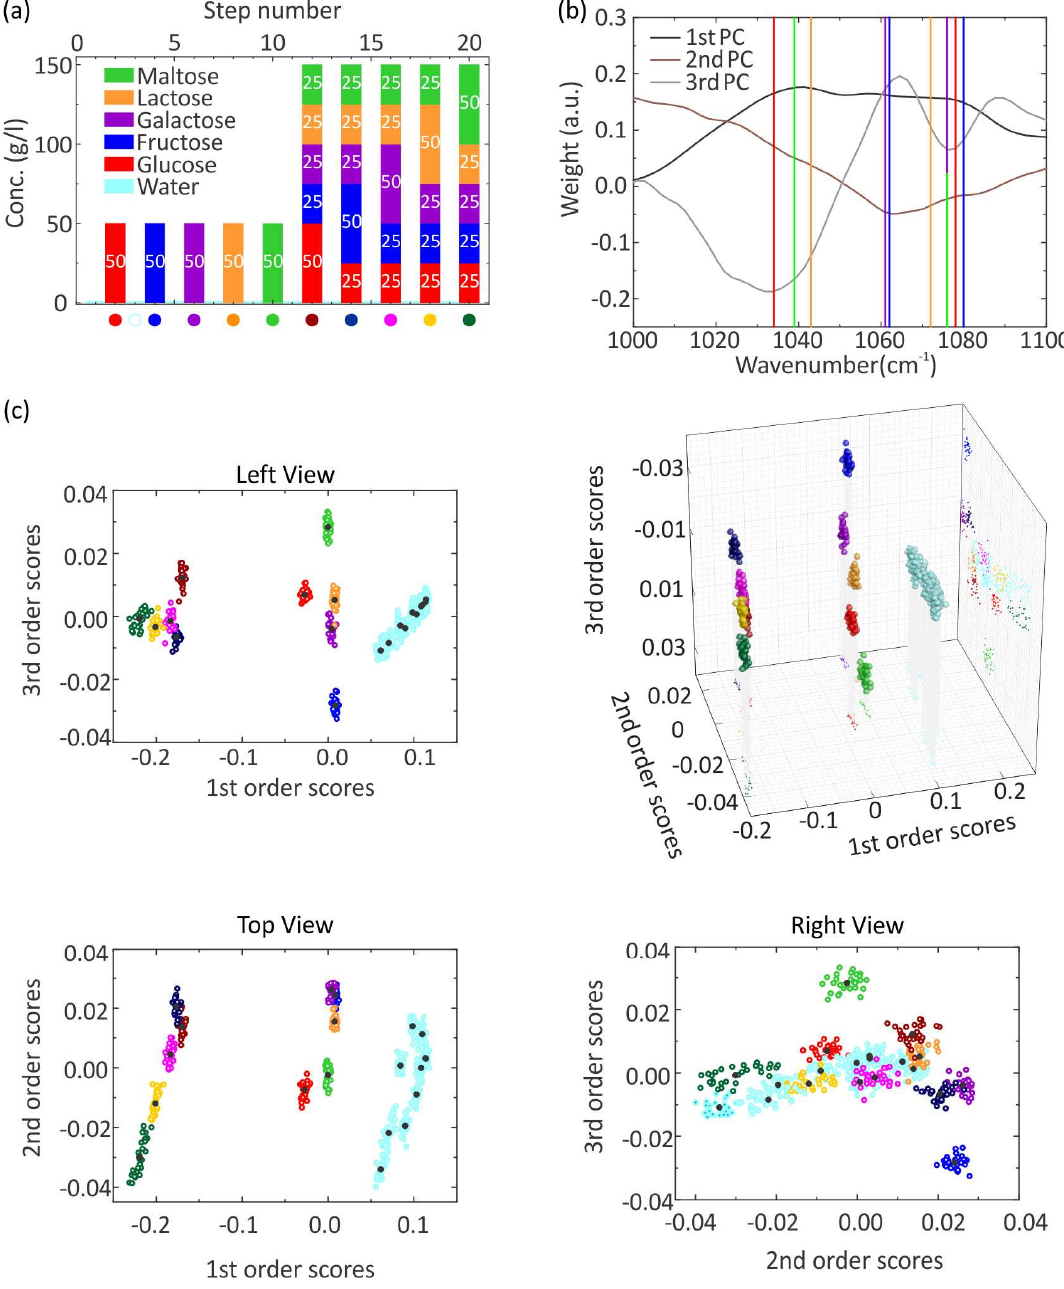
Figure 5. ( a ) Measurement cycle of pure and mixed aqueous sugar solutions of glucose, fructose, galactose, lactose, and maltose as well as water, whereas 30 spectra are taken for each step. The